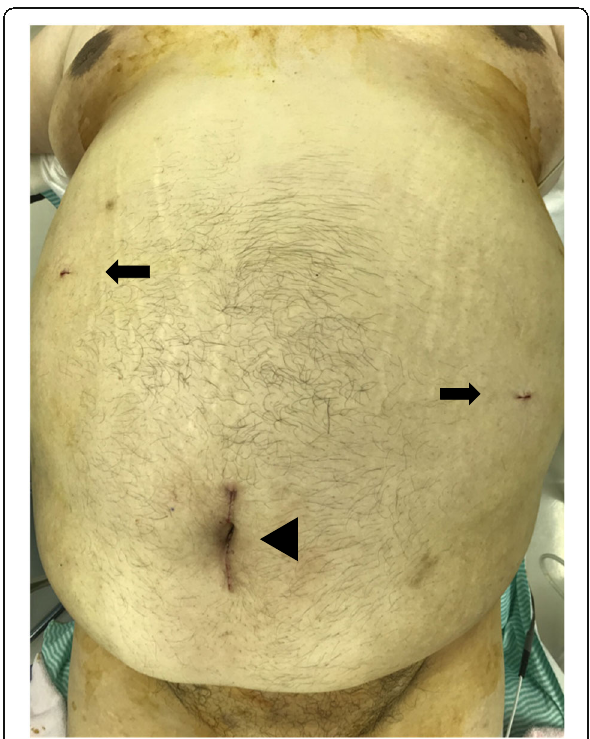
Fig. 5 Skin incision wound immediately postoperatively. The Alexis® laparoscopic system insertion site (arrowhead) and insertion sites for 5-mm trocars (arrows) are